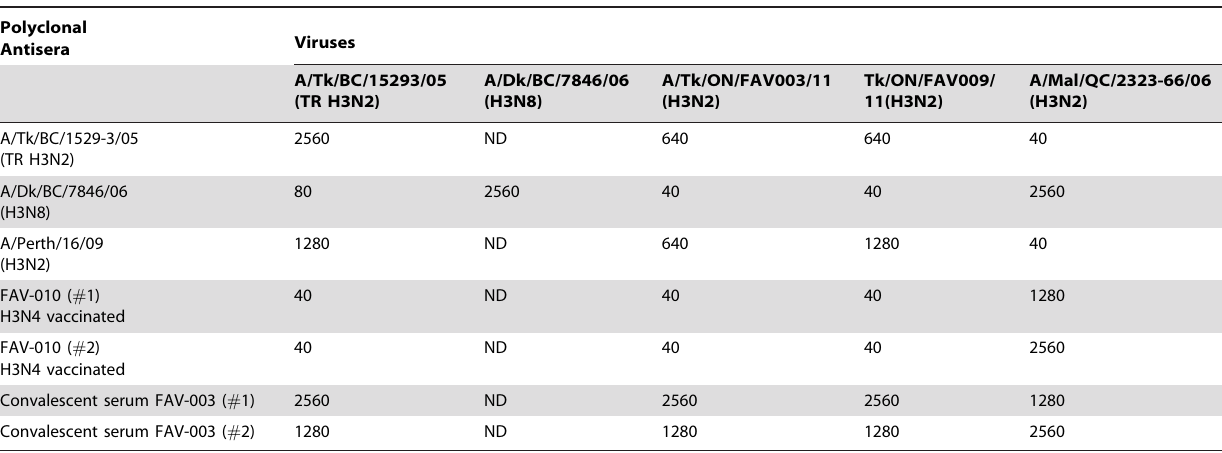
Table 5. Summary of cross neutralization assay results as determined by IPRVN of TR H3N2 viruses isolated from turkeys using various reference H3